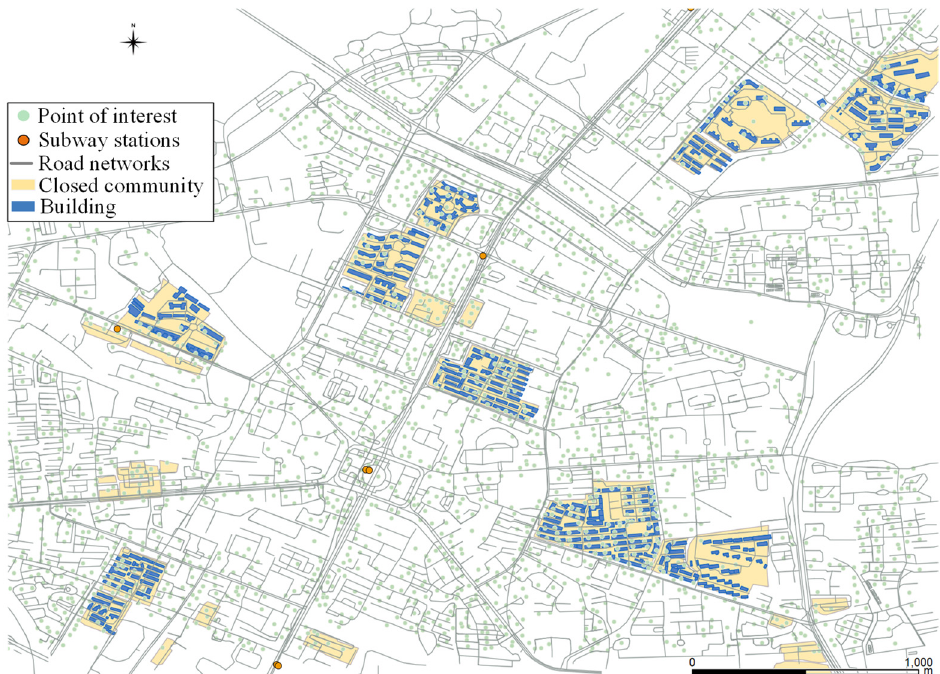
Figure 5. Data used for accessibility measurement.